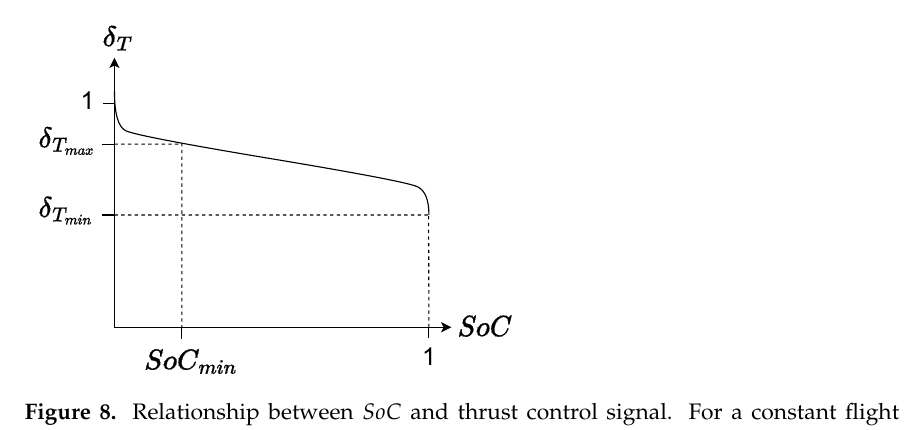
Figure 8. Relationship between SoC and thrust control signal. For a constant flight condition, the required δ T increases depending on the battery discharge